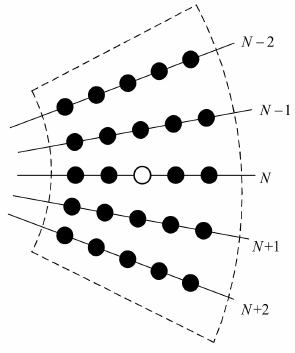
Figure 2. Window centered on the